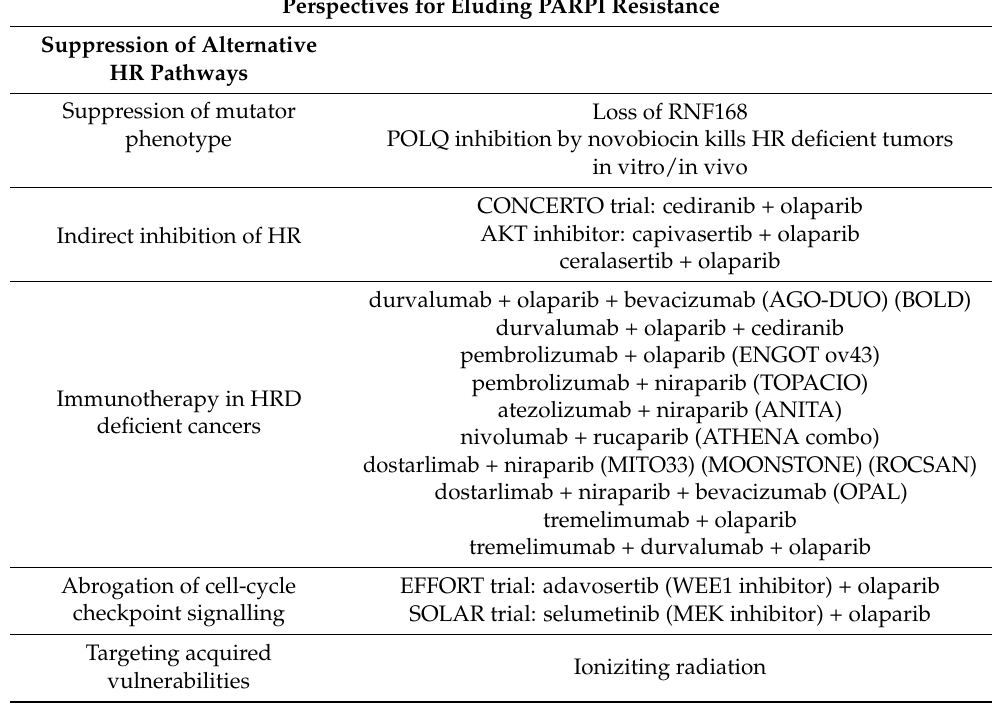
Table 1. Perspectives for eluding resistance to PARP inhibitors. Potential strategies to enhance the efficacy of poly(ADP-ribose) polymerase (PARP) inhibitors in treatment-resistant tumors. Perspectives for Eluding PARPI